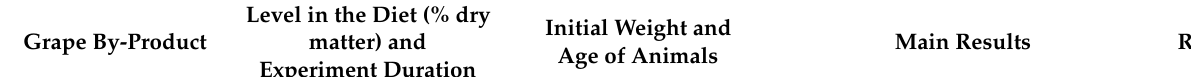
Table 3. Main effects of dietary inclusion of grape by-products on poultry meat quality